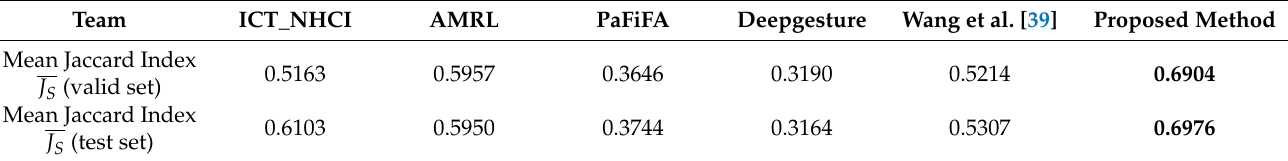
Table 7. Performance comparison with other teams in ChaLearn LAP Large-scale Continuous Gesture Recognition Challenge. Team